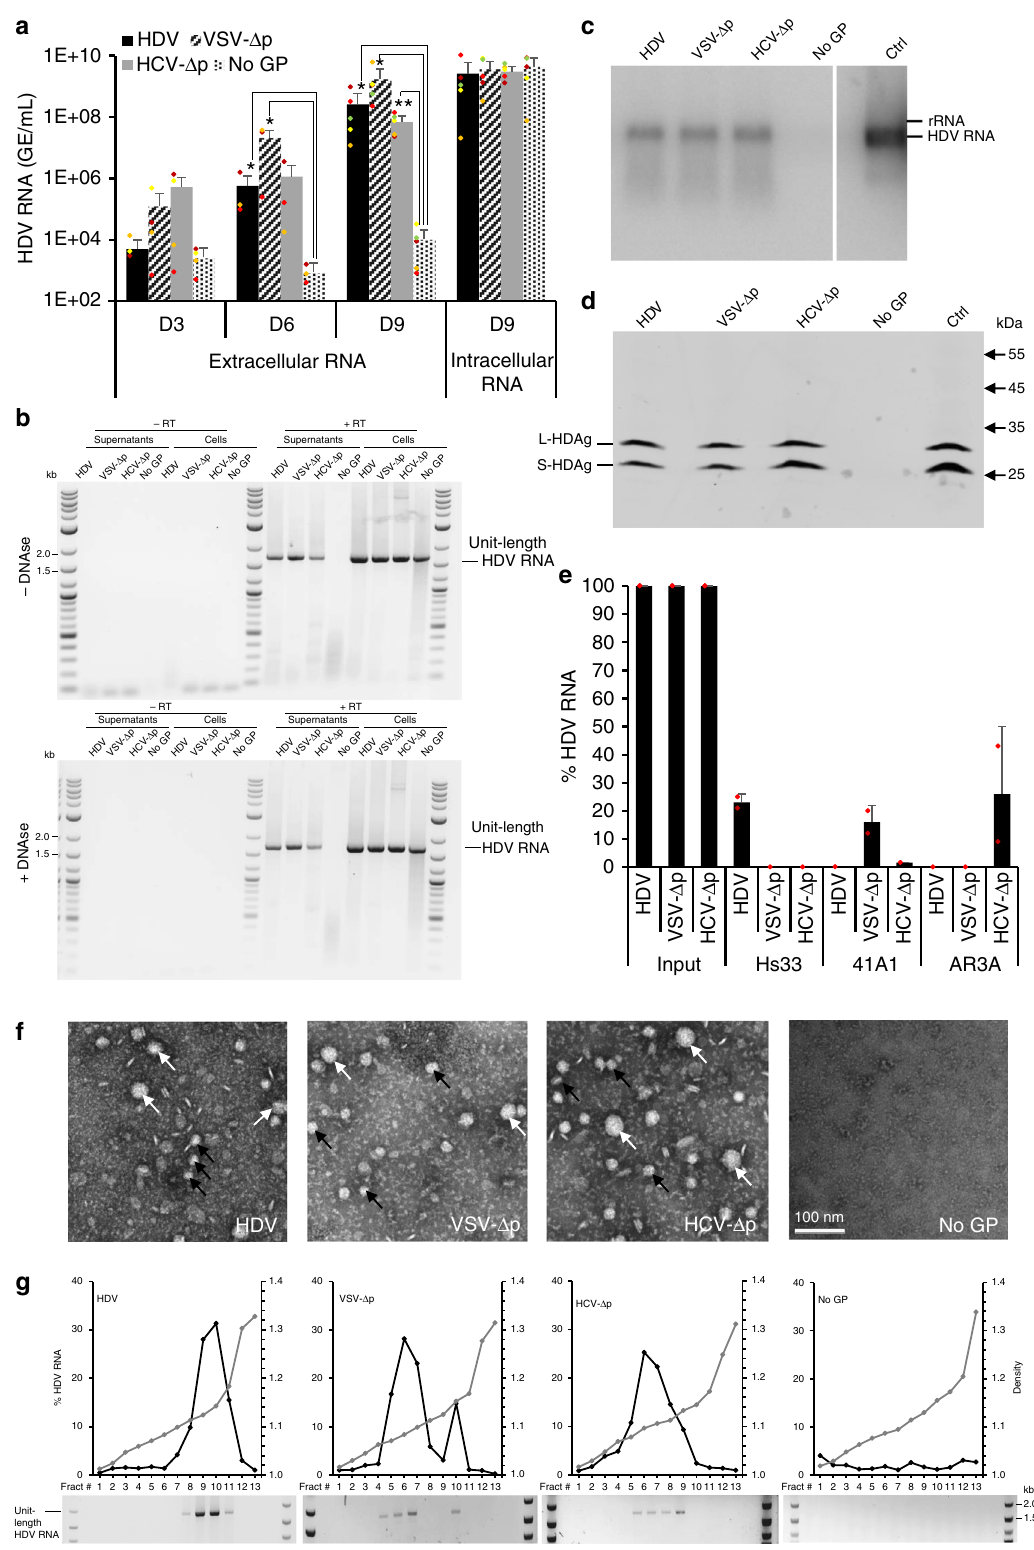
these results indicated that HDV can be enveloped by different types of viral surface glycoproteins, which induces secretion of HDV RNPs in the extracellular milieu. To further characterize the non-HBV-induced HDV particles ( Δ p) coated with VSV-G or HCV-E1E2 envelope GPs, hereafter designated VSV- Δ p and HCV- Δ p, we incubated the